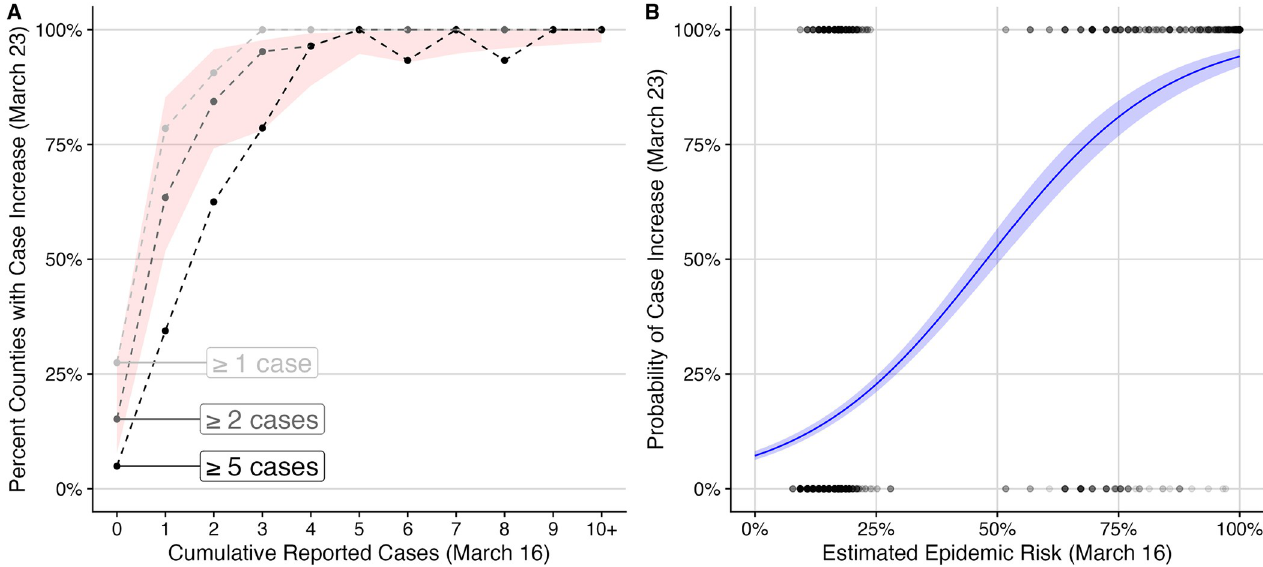
Fig 4. Comparison of estimated epidemic risks and reported increases in cases at the county level between March 16 and March 23, 2020. (A) Proportion of all US counties that had specified one-week increase in reported COVID-19 cases, compared to the cumulative case count in the county as of March 16, 2020 (x-axis) [16]. The light, medium and dark gray lines correspond to increases of at least one, two, or five new reported cases within one week, respectively. The red ribbon indicates model estimates for the probability that an epidemic is underway, depending on the cumulative reported cases. The bottom and top of the ribbon correspond to estimates for the lowest and highest risk counties across the United States, where risk is estimated based on county-specific estimates of R e and the cumulative number of reported cases on March 16. These estimates are calculated based on 100,000 simulations for each reproduction number ( R e = 1.4 to 4.4 by 0.1), assuming a 10% case detection rate and a generation time of 6.0 days. (B) Estimates of epidemic risks on March 16 correlate with case count increases in the subsequent week across all counties. Points indicate whether counties reported at least two new COVID-19 cases between March 16 and March 23, where the bottom and top of the graph correspond to counties that did or did report such increases. The line and shading indicate the estimated mean (line) and 95% confidence interval (ribbon) resulting from a logistic regression relating actual one-week reported increase to estimated risk on March 16, 2020. We estimate that a 10% increase in estimated risk corresponds to a 0.53 (95% CI: 0.49–0.58) increase in the log odds that the county reported at least two additional cases in the following